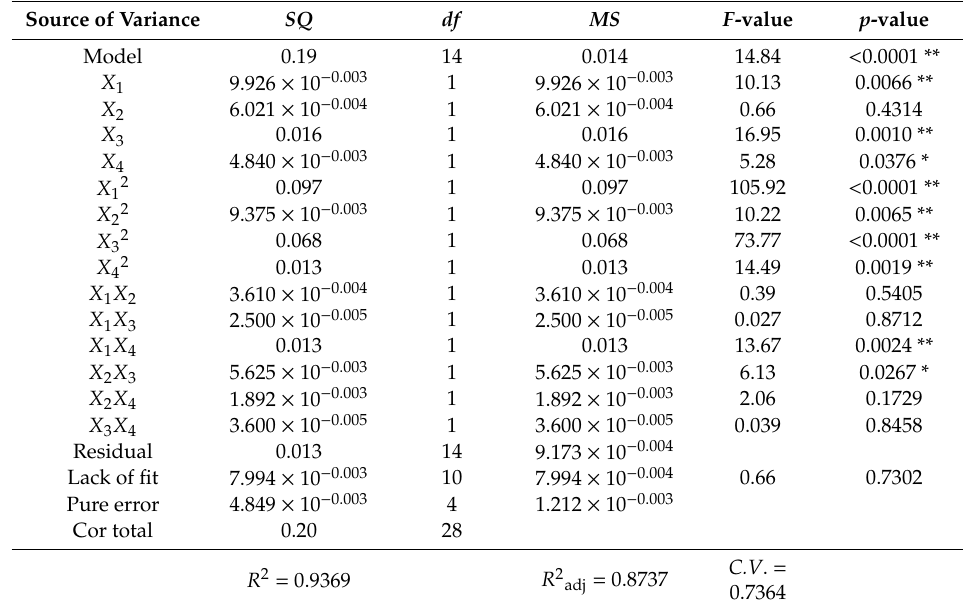
Table 4. Significance test report of the regression model coe ffi cient of anthocyanins extracted from raspberries by ultrasound-assisted deep eutectic solvent extraction